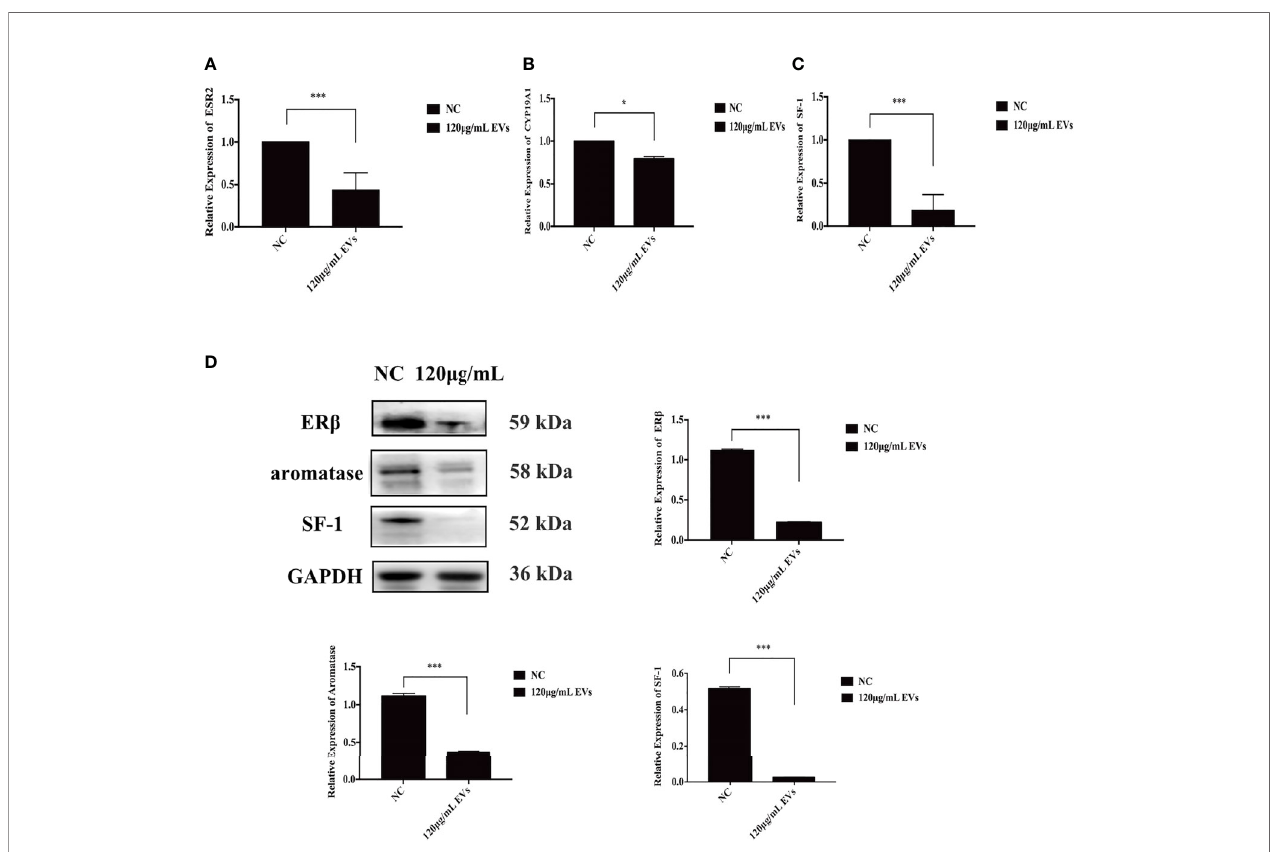
FIGURE 4 | EVs inhibit expression of SF-1, aromatase, and ER b in ESCs. EVs have a certain inhibitory effect on the expression of estrogen-related genes in ESCs. (A – C) ESCs were collected for qRT-PCR. At the mRNA level, compared with the control group, the expression of ESR2, CYP19A1, and SF-1 decreased by 81.67% (n = 6, P = 0.000), 21.50% (n = 6, P = 0.04), and 51.64% (n = 6, P = 0.000), respectively. (D) ESCs were collected for western blotting analysis using anti-ER b , anti- SF-1, and anti-aromatase antibodies. The protein expression of ER b , SF-1, and aromatase decreased (n = 6, P = 0.000 for all proteins). All experiments were repeated three times.*P < 0.05, ***P < 0.001 vs. individual controls. Data in qRT-PCR and wWestern blotting were shown as mean ± standard deviation. Independent sample t-test was used between two groups of